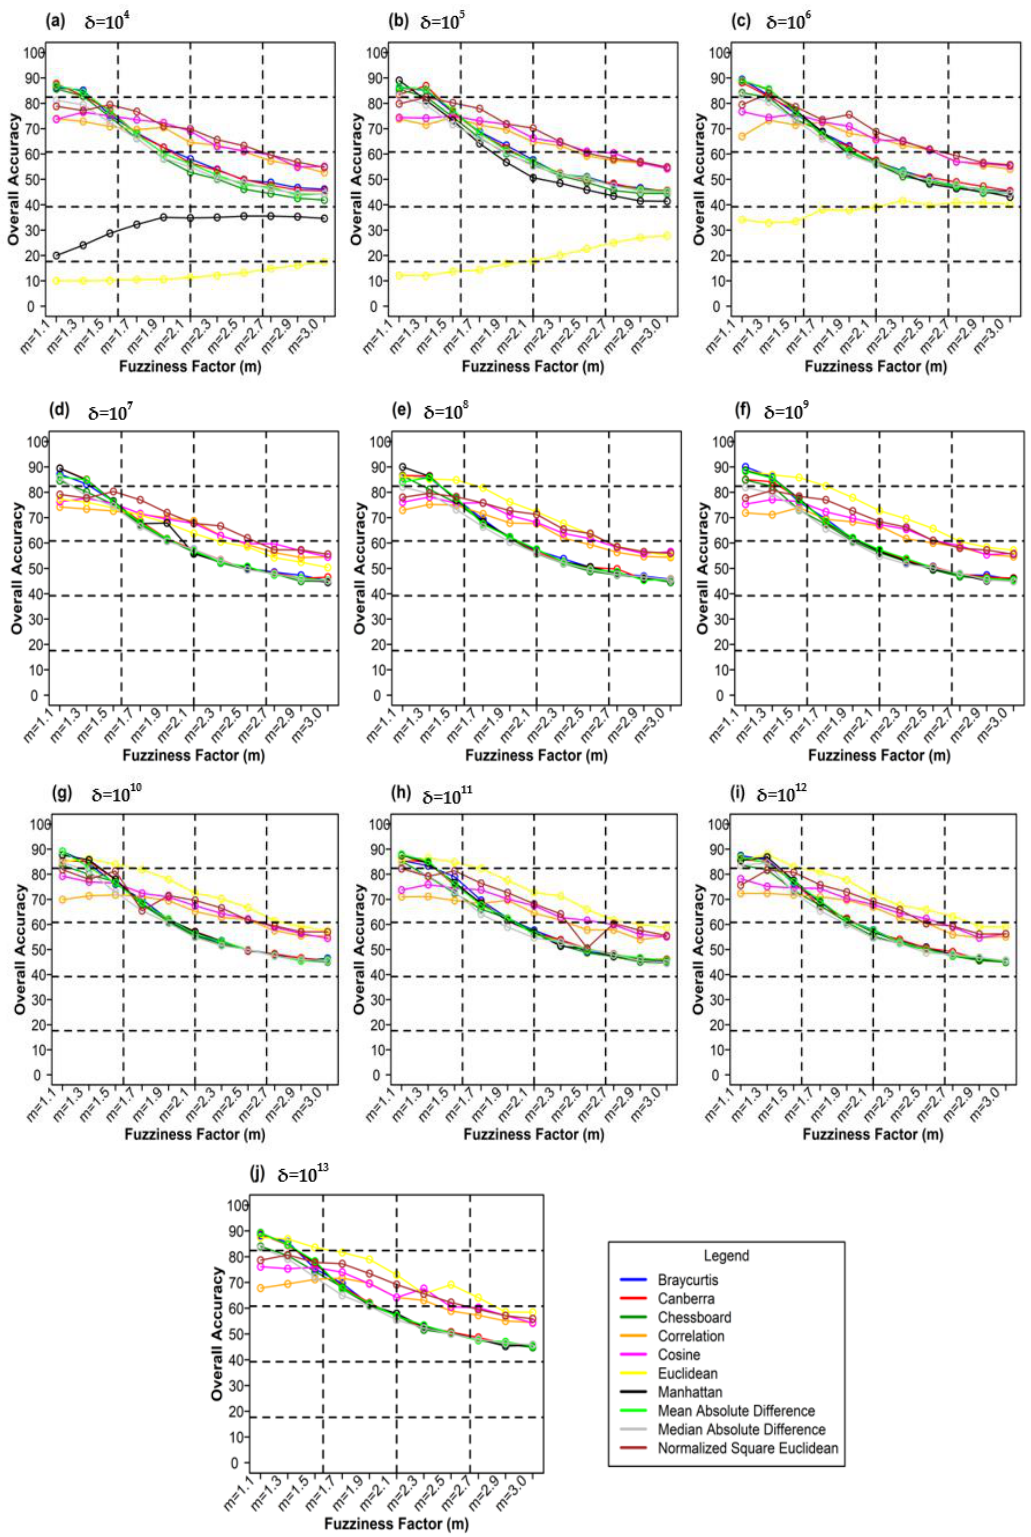
Figure 13. Comparison of overall accuracy in NC_S classifier for applying different distance measures, m (1.1–3.0), and ( a – j ) for site 1 (Haridwar).